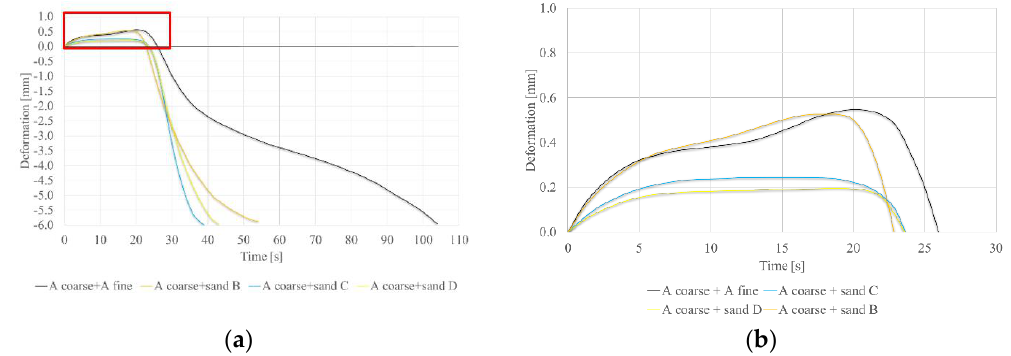
( b ) Figure 17. Hot-deformation curves of specimens made of tested sands: ( a ) general view, ( b ) detail. The graph in the Figure 18 displays the results of the hot distortion test for combinations of sands